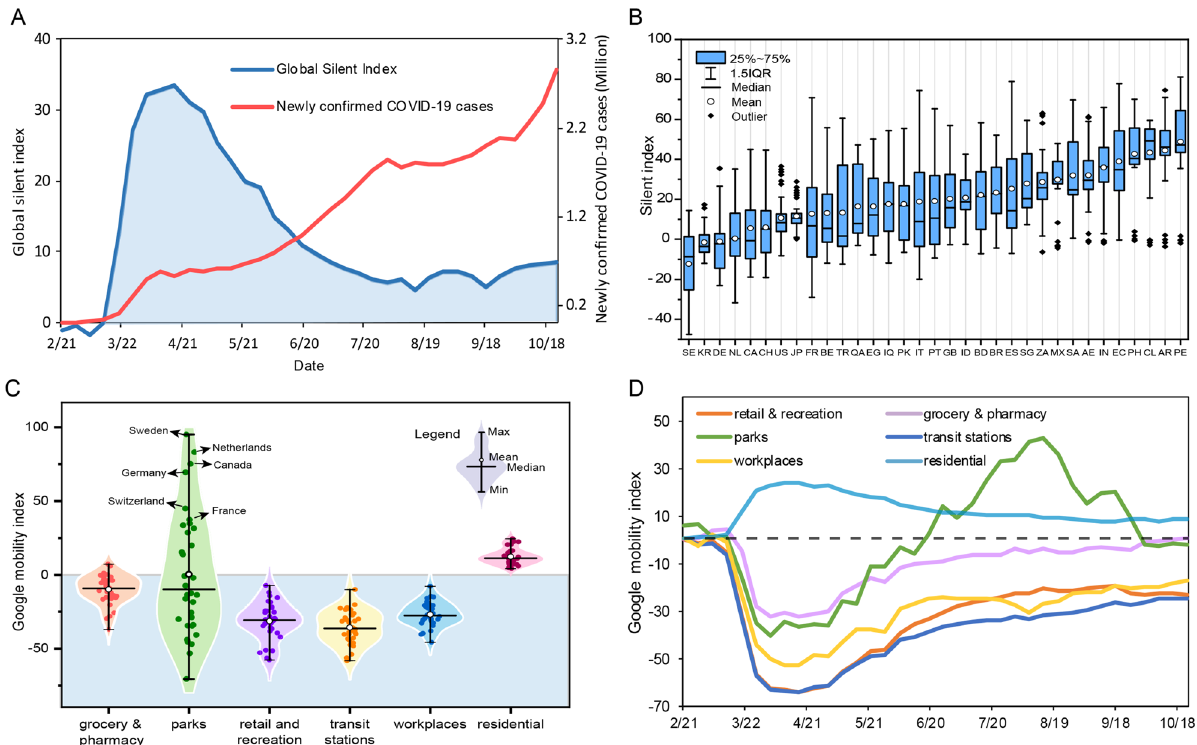
Figure 1. Variation of the silent world globally, nationally and by place. ( A ) Temporal variation of global SI and the number of newly confirmed COVID-19 cases from 126 countries from the baseline day to middle October 2020. ( B ) Box-plot of SI since the 100 confirmed COVID-19 cases reported in 33 selected countries. ( C ) Violin- plot of Google mobility index (see Methods) by six place categories in 33 countries. ( D ) Temporal variation of mobility in six places in 33